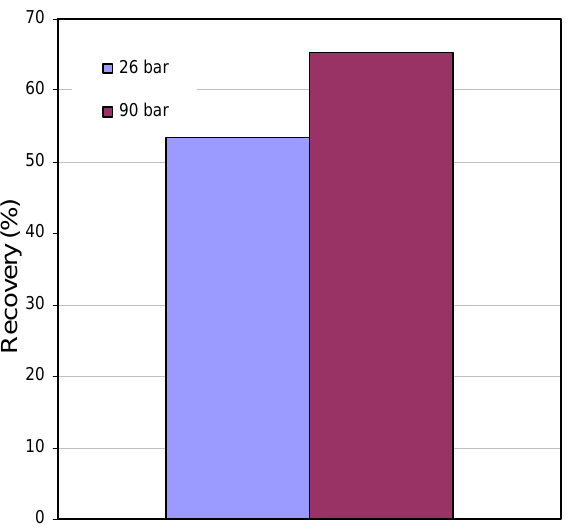
Figure 1. Comparison between the oil recoveries of non-asphaltenic oil (0.005 M stearic acid (SA) dissolved in n -decane ( n -C at 25 °C, 90 and 26 bar